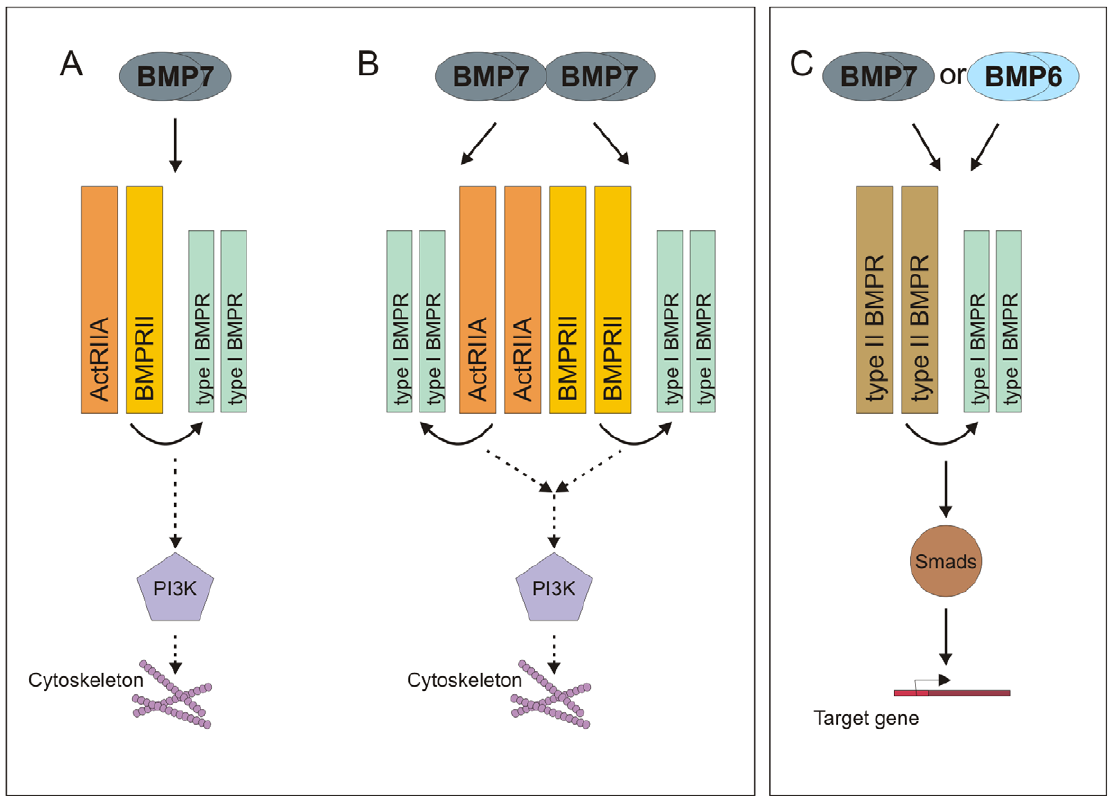
Figure 8. Model of differential receptor subunit recruitment and signaling underlying BMP-evoked chemotaxis and trophic actions. We have demonstrated that ActRIIA and BMPRII receptor subunits are both selectively required for BMP7-evoked chemotaxis in monocytic cells. How do the individual receptor subunits contribute to this activity? Do they work together in a common complex? A,B: Our data support a model in which BMP7 engages both ActRIIA and BMPRII subunits either as part of a heteromeric type II receptor pair (A) or as homodimers, possibly forming unique receptor complexes combining pairs of each of the type II receptor subunits (B). The identity of the type I receptors that contribute to this complex is not known, although recent evidence implicates BMPRIB in BMP-dependent axon guidance [48,49]. Engagement of ActRIIA and BMPRII subunits by chemotropic BMPs activates a signaling pathway leading to PI3K activity and cytoskeletal reorganization that is independent of Smad4-mediated nuclear signaling. C: In contrast, BMP6 does not stimulate chemotaxis, presumably being unable to recruit or activate the ActRIIA:BMPRII complex necessary for chemotropic signaling. In the same cell, however, BMP7 and BMP6 share the ability to activate Smad-dependent transcriptional pathways, through receptor mechanisms that do not depend selectively on either ActRIIA or